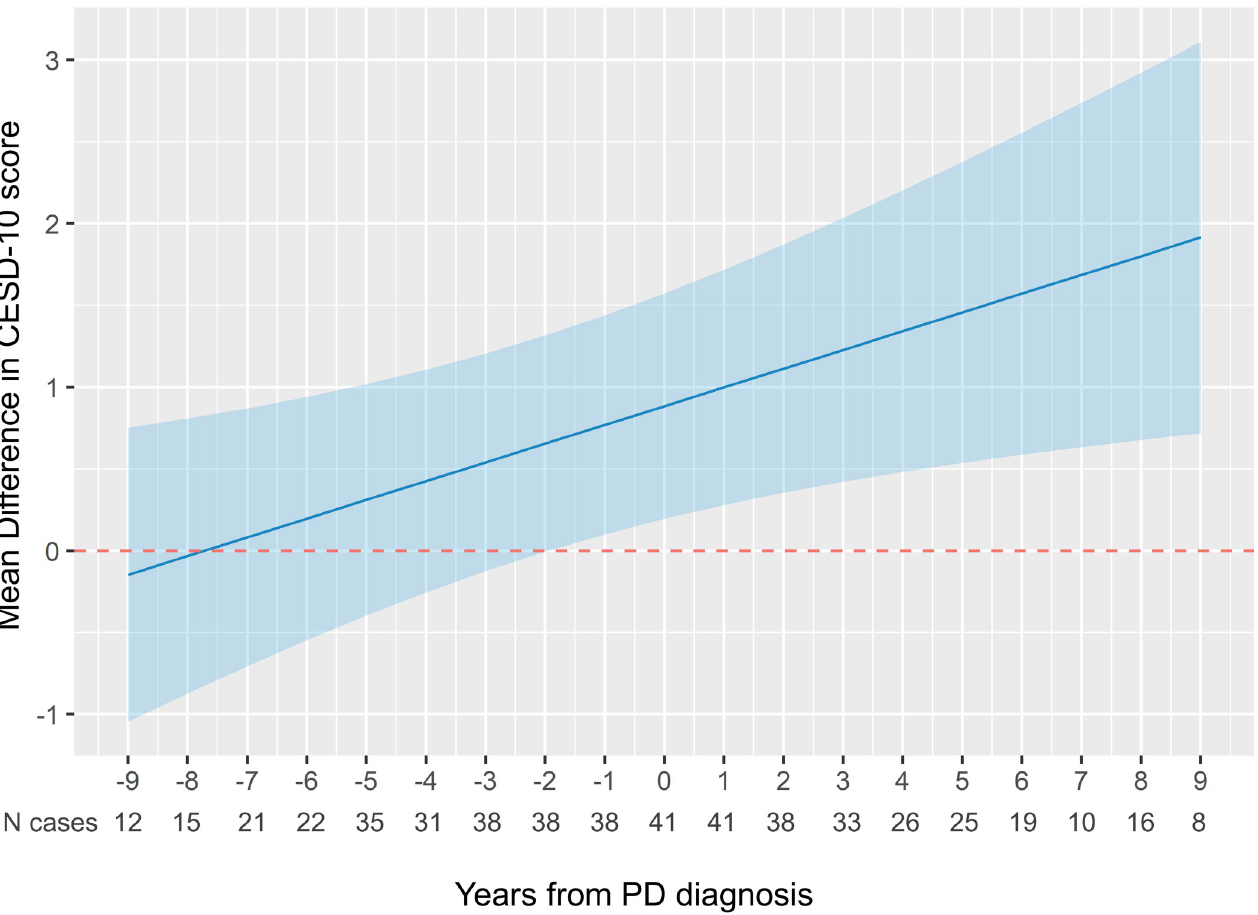
Fig 1. Mean difference in CESD-10 score before and after PD diagnosis. Y-axis represents the mean difference of CESD-10 score of a PD case versus its expected value had the participant not developed PD. The blue band represents the 95% confidence interval. Model adjusted for the linear and quadratic terms of clinic visit year, baseline age, sex, race, study site, and education, and the time-varying marital status, general health status, smoking status, and antidepressant use, and accounting for the competing risks of non-participation and death. PD: Parkinson’s disease; CESD: Center for Epidemiologic Studies Depression